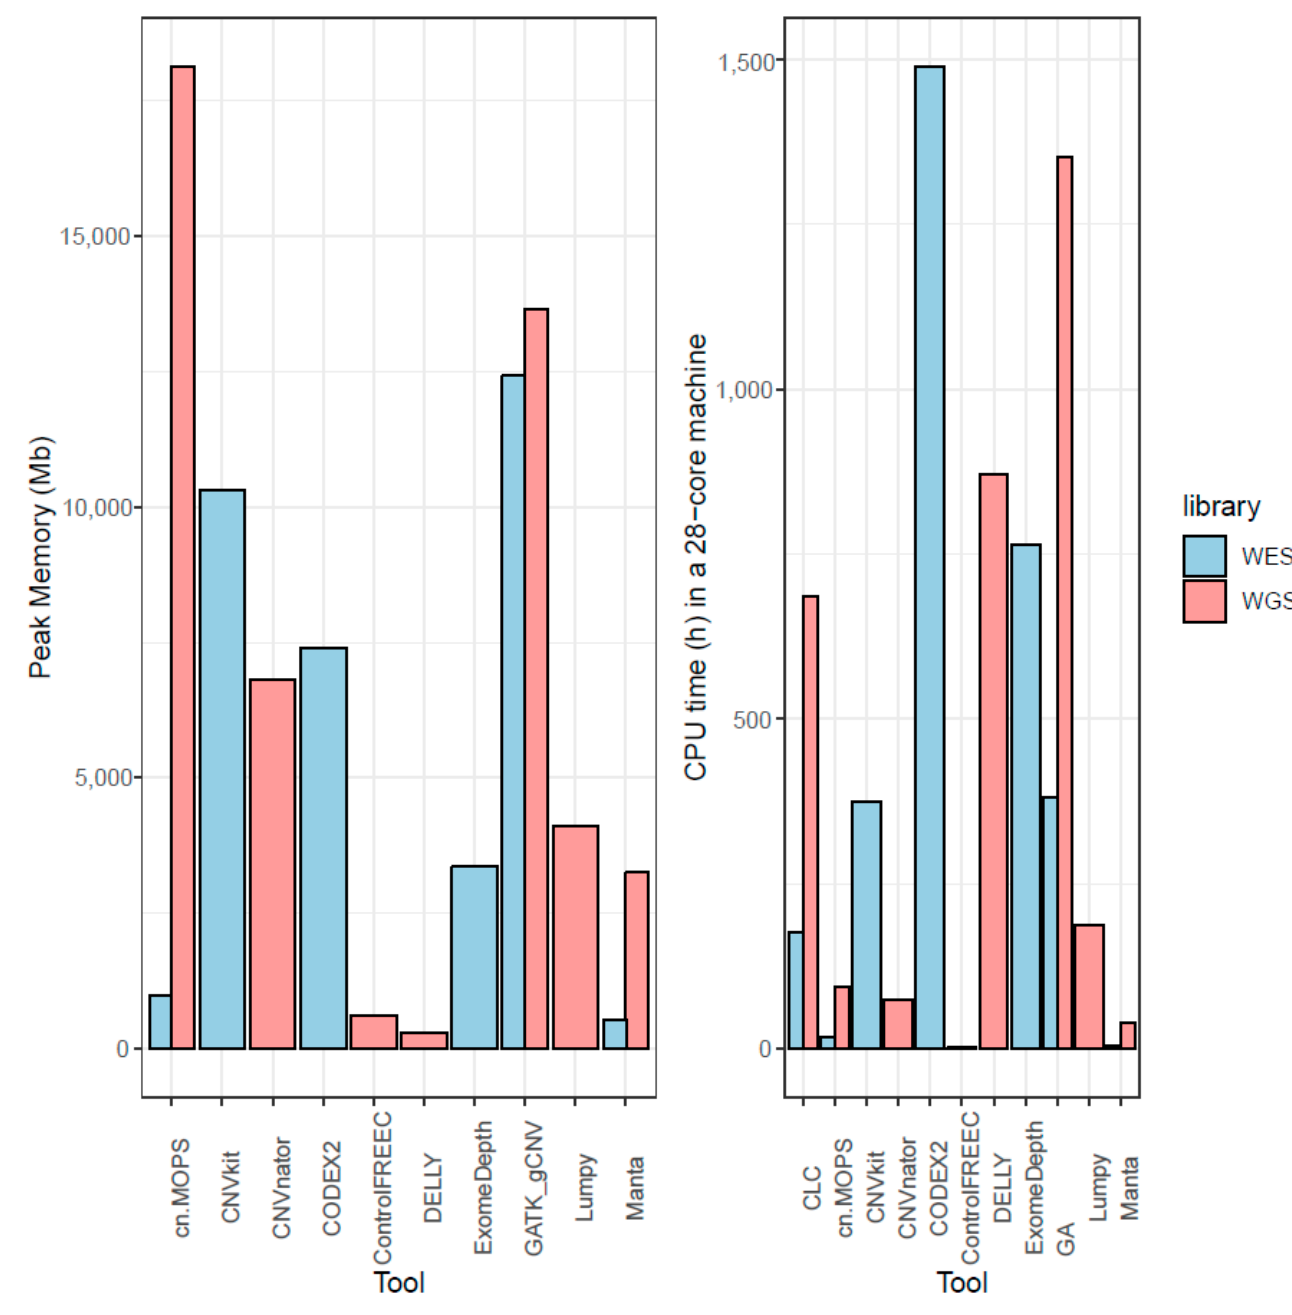
Figure 7. Maximum memory used by a tool measured in megabytes and total CPU time in hours run in 28-core machines with 128 GB RAM, while running NA12878. Some tools can distribute tasks over nodes, and total RAM usage is reported as total